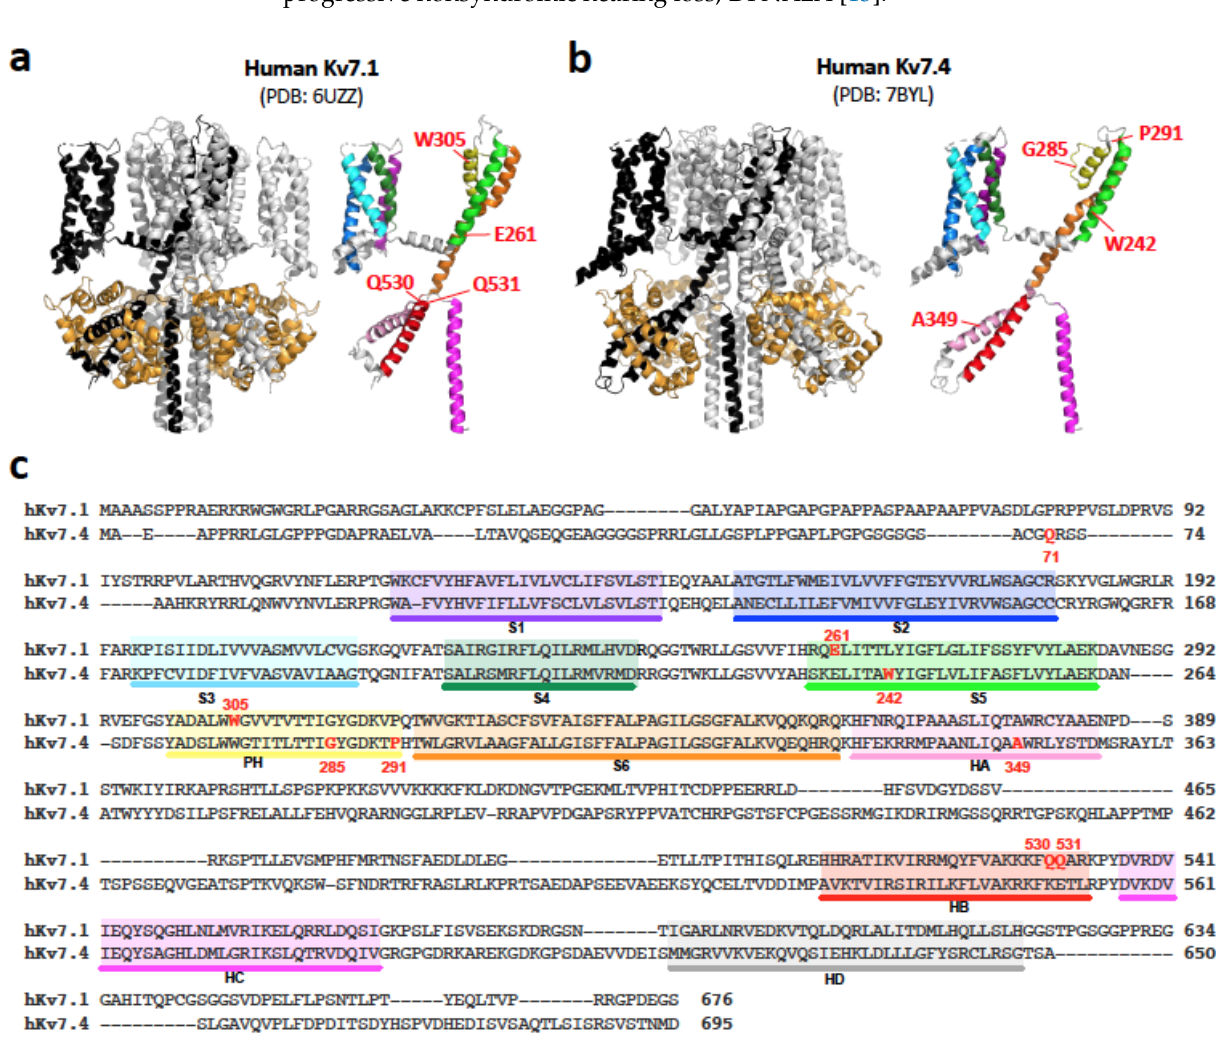
Figure 1. The structures of human Kv7.1 ( a ) and human Kv7.4 ( b ). One of the four protomers and four bound calmodulins (one calmodulin per protomer) are shown in black and pale orange, respec- tively. In both ( a ) and ( b ), a single protomer is shown on the right. The residues referred to in the main text are shown in red. ( c ) The amino acid sequences of human Kv7.1 and human Kv7.4. The highlights indicate helices, whose colors are matched with those used in ( a , b ).